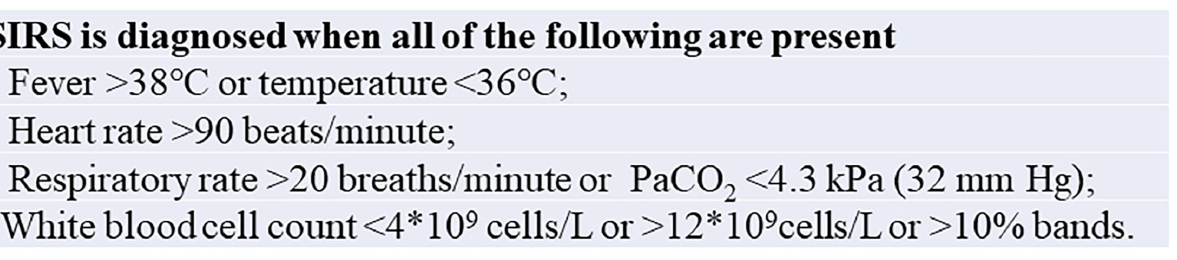
FIGURE 2 | Clinical diagnosis of the sSIRS. sSIRS, severe systemic inflammatory response